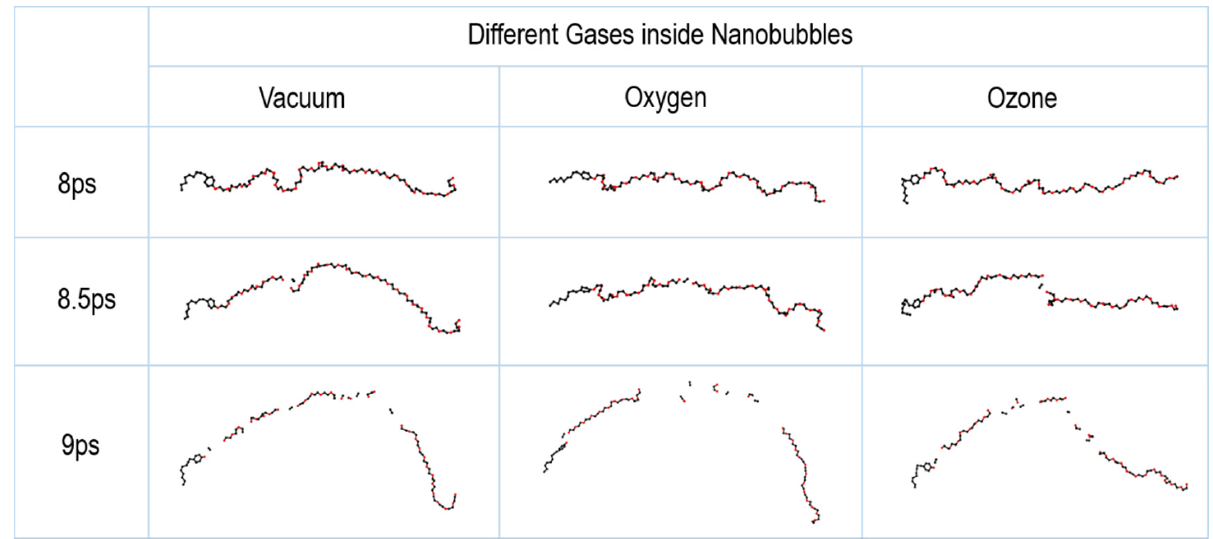
Figure 5. The morphology changes of the pollutant molecule and its fracture due to the collapse of different nanobubbles.